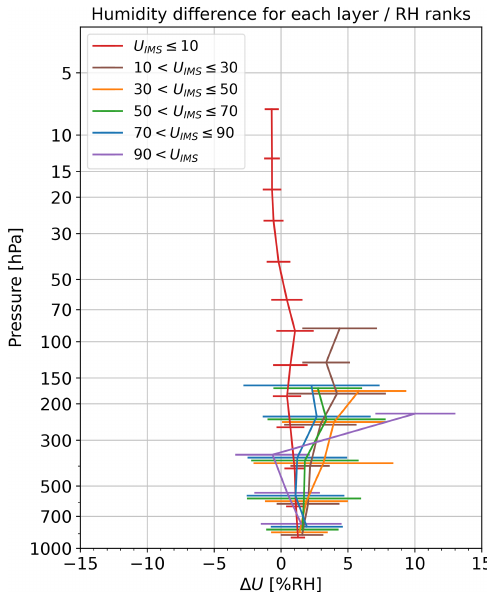
Figure 22. Mean RH difference for six RH